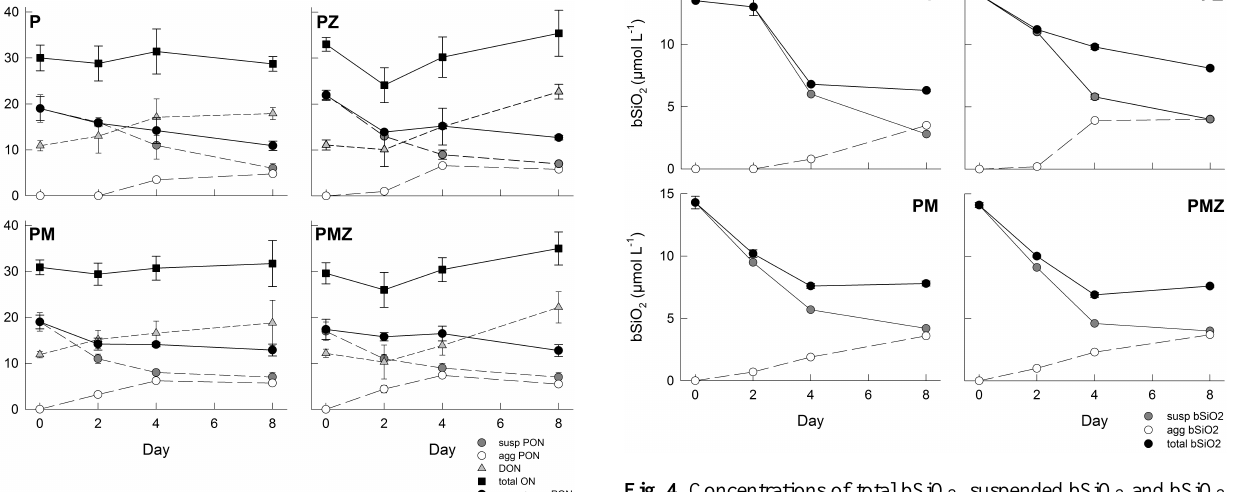
Fig. 4. Concentrations of total bSiO 2 , suspended bSiO 2 and bSiO 2 in aggregates in the 4 treatments during the